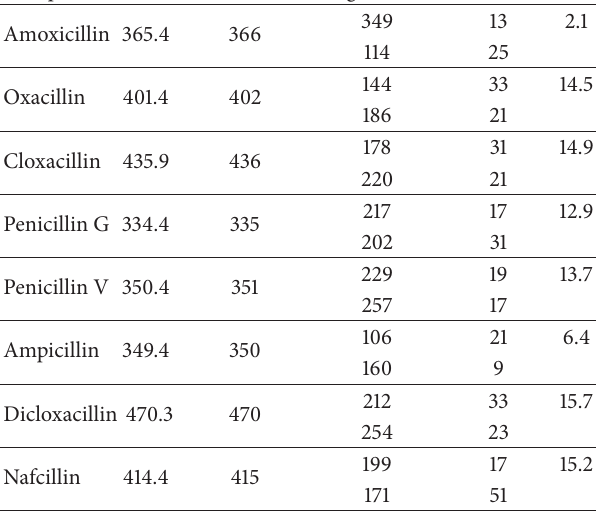
Table 3: MRM transitions of each analyte and collision energy (CE) for mass spectrometry detection and chromatographic retention